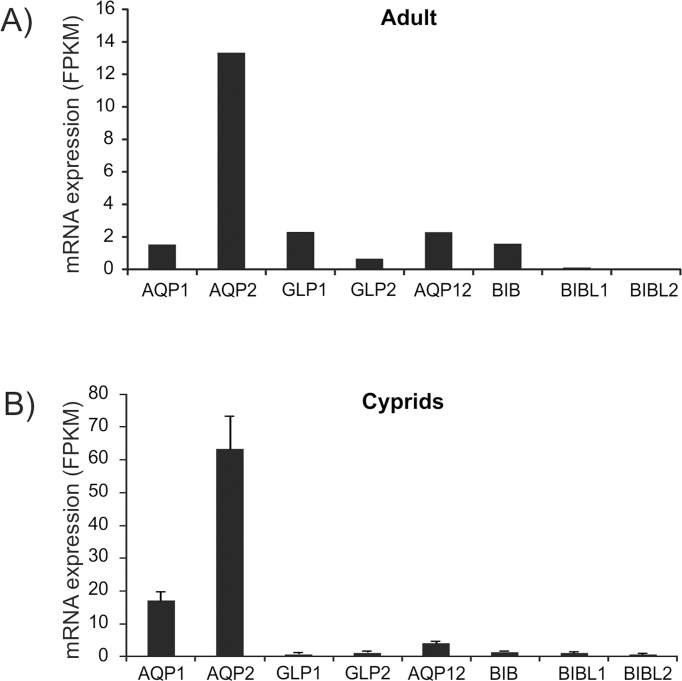
mRNAexpression of aquaporins in B. improvisus.The mRNA expression of the B. improvisus aquaporins was determined by RNA-seq in an adult (A) and in cyprid larvae (B) cultivated at seawater salinity (≈ 30 PSU). Total RNA was prepared and sequenced by paired-end Illumina sequencing. Normalized expression levels for the aquaporins were estimated by mapping reads to the aquaporins ORFs using the program RSEM. The expression levels for the different AQP genes are shown as FPKM (Fragments Per Kilobase of transcript per Million mapped reads) for the adult and TMM-normalized FPKM for cyprids. The sample sizes were n = 1 for the adult and n = 4 for the cyprids, with 300 cyprids pooled in four independent replicates. Error bars for the cyprid batches in B shows standard deviation. AQP2 was significantly higher expressed in cyprids compared to all the other aquaporins (ANOVA, P<0.001; see supplementary S1 Table for significant changes for all pair-wise comparisons). Absolute expression values should not be compared between life stages due to lack of normalization between the life stages.